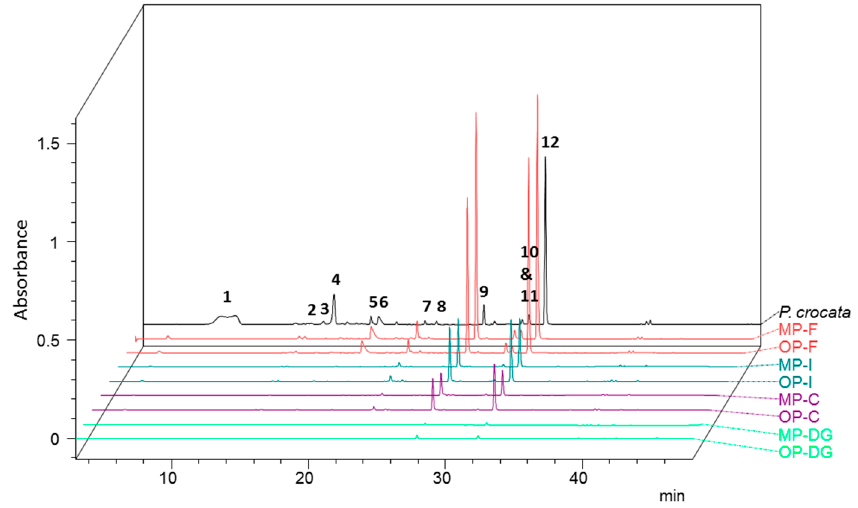
Figure 5. PDA chromatogram at 254 nm of acetone extracts of N. hookeri digestive gland (DG, green curves), crops (C, purple curves), intestines (I, blue curves), and feces (F, red curves) after being fed with P. crocata (black curve). These profiles are compared according to their phenotype (MP = mineral, PBAS sample; OP = organic, MAS sample).